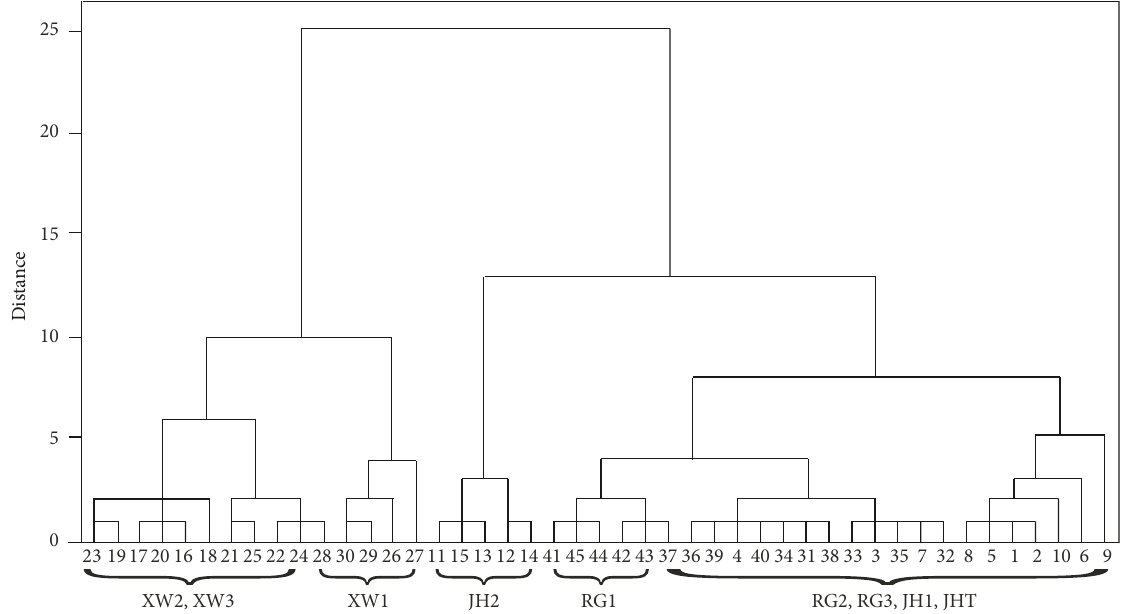
Figure 3: Cluster analysis (CA) chart of three kinds of dry-cured hams by the electronic nose. JHT: 1-5, JH1: 6-10, JH2: 11-15, XW3: 16-20, XW2: 21-25, XW1: 26-30, RG3: 31-35, RG2: 36-40, and RG1: 41-45. The abbreviations in the figure are referred to in Grades of Ham Samples and Their Abbreviations.